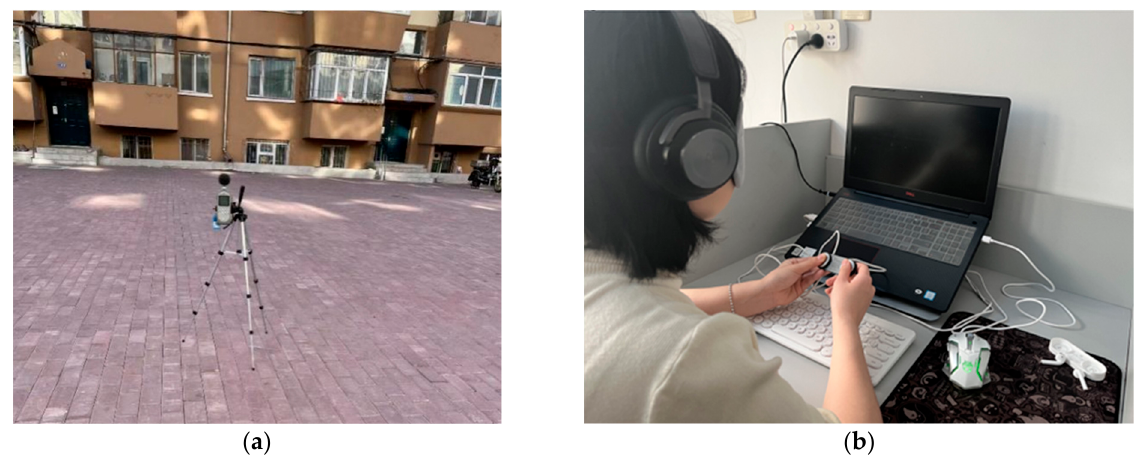
Figure 2. Test instruments: ( a ) acoustic environment test and ( b ) physiological measurement.